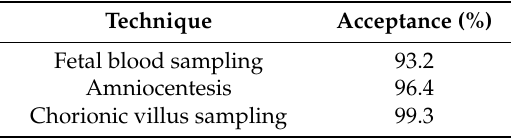
Table 5. Acceptance of prenatal diagnosis of β -thalassemia according to the invasive